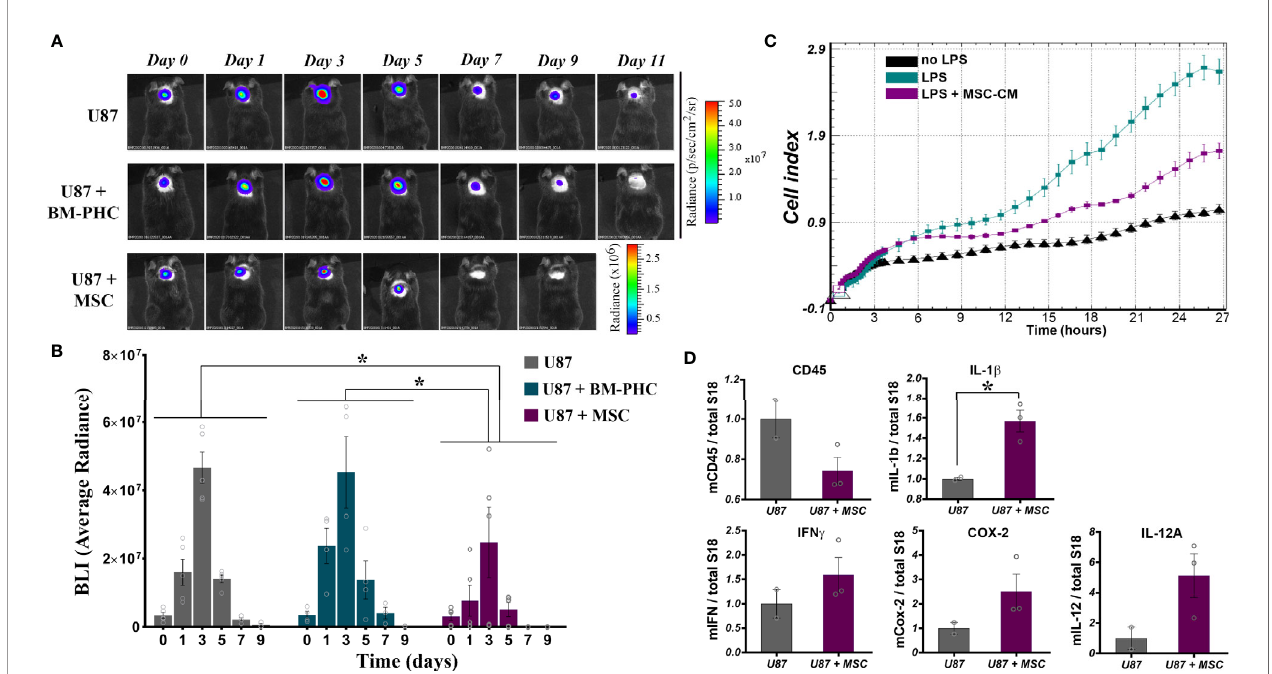
FIGURE 6 | The effects of BM-PHC and MSC on tumor development in immunocompetent mice. (A) A representative bioluminescent image of C57Bl/6 mice subcutaneously transplanted with U87 cells alone (U87) or in the presence of BM-PHC or MSC is given above for each time point analyzed. (B) The diagram illustrates the bioluminescence signal of the tumor cells in all three groups, determined as average radiance. Values represent means+/-SEM of n=4-5 animals/group. (C) Dynamic assessment (original recording) of the effect of MSC secretome on macrophage activation in the presence of LPS. The recording represents mean values obtained from triplicates of one representative experiment from 2 experiments. (D) Quanti fi cation by real time RT-PCR (n = 2-3 per group) of the relative expression of genes associated with in fl ammation in cellular aggregates of tumor cells extracted after 5 days from implantation. *p <